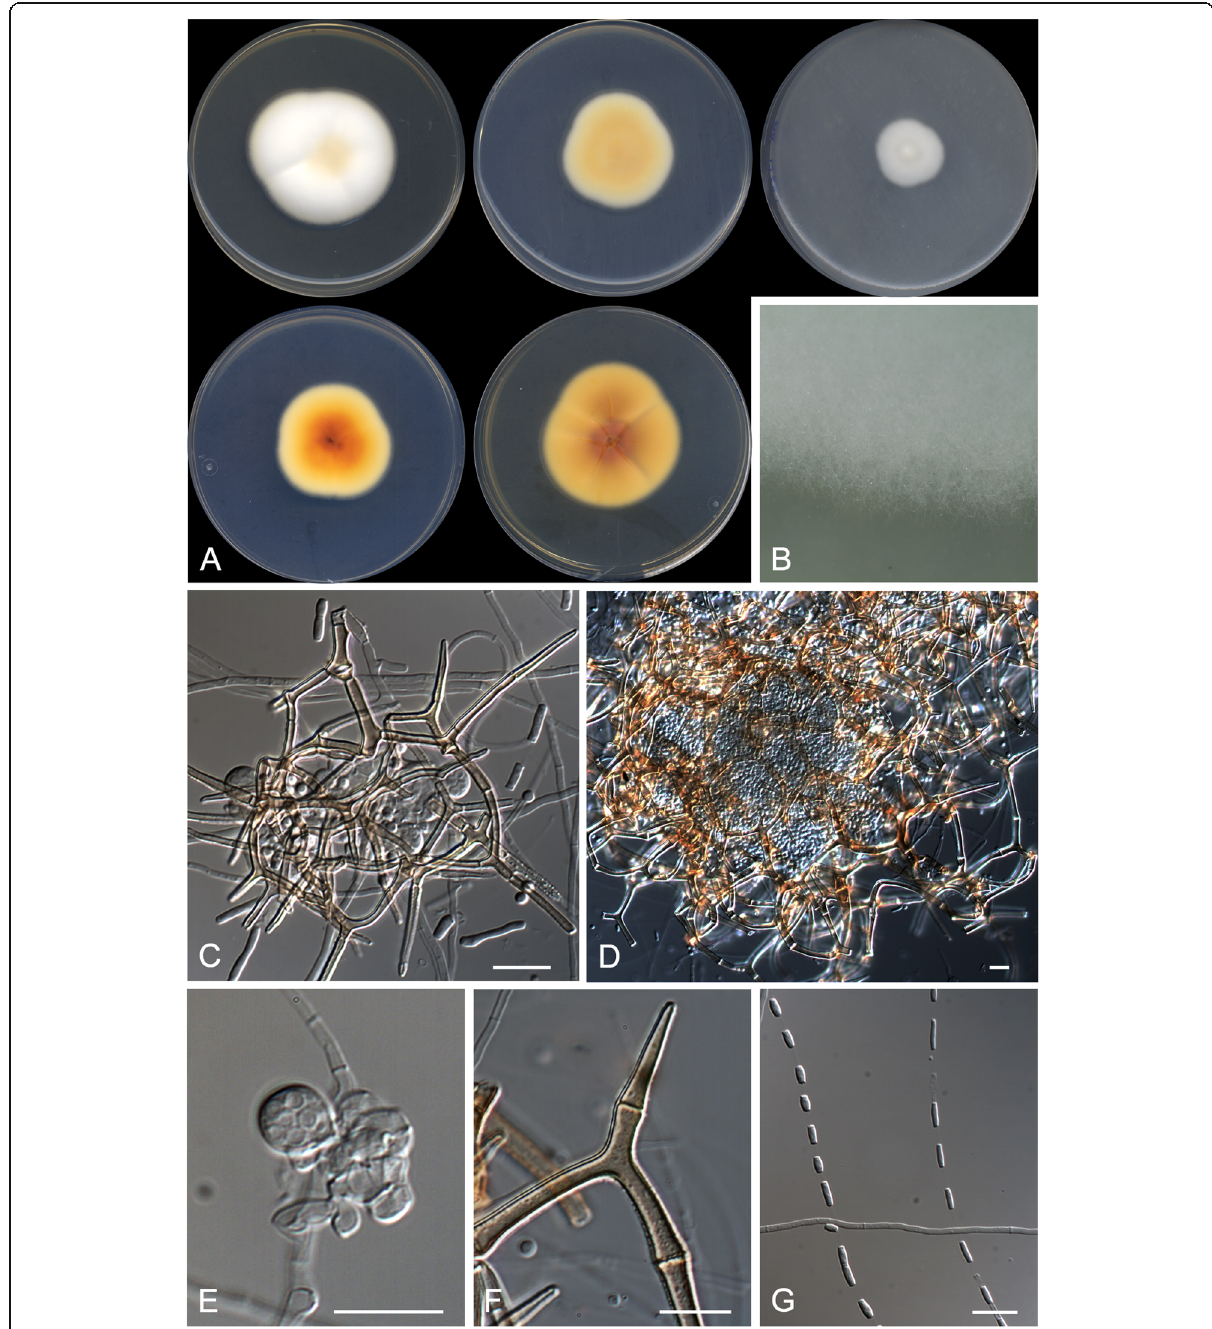
Fig. 6 Malbranchea gymnoascoides CBS 146930 T . a Colonies on PYE, PDA and OA after 14 d at 25 °C, from left to right (top row, surface; bottom row, reverse). b Detail of the colony on OA. c – d Young and mature ascomata. e Young ascus on fertile hyphae. f Peridial spine-like appendage. g Intercalary arthroconidia along the fertile hyphae. Scale bar = 10 μ